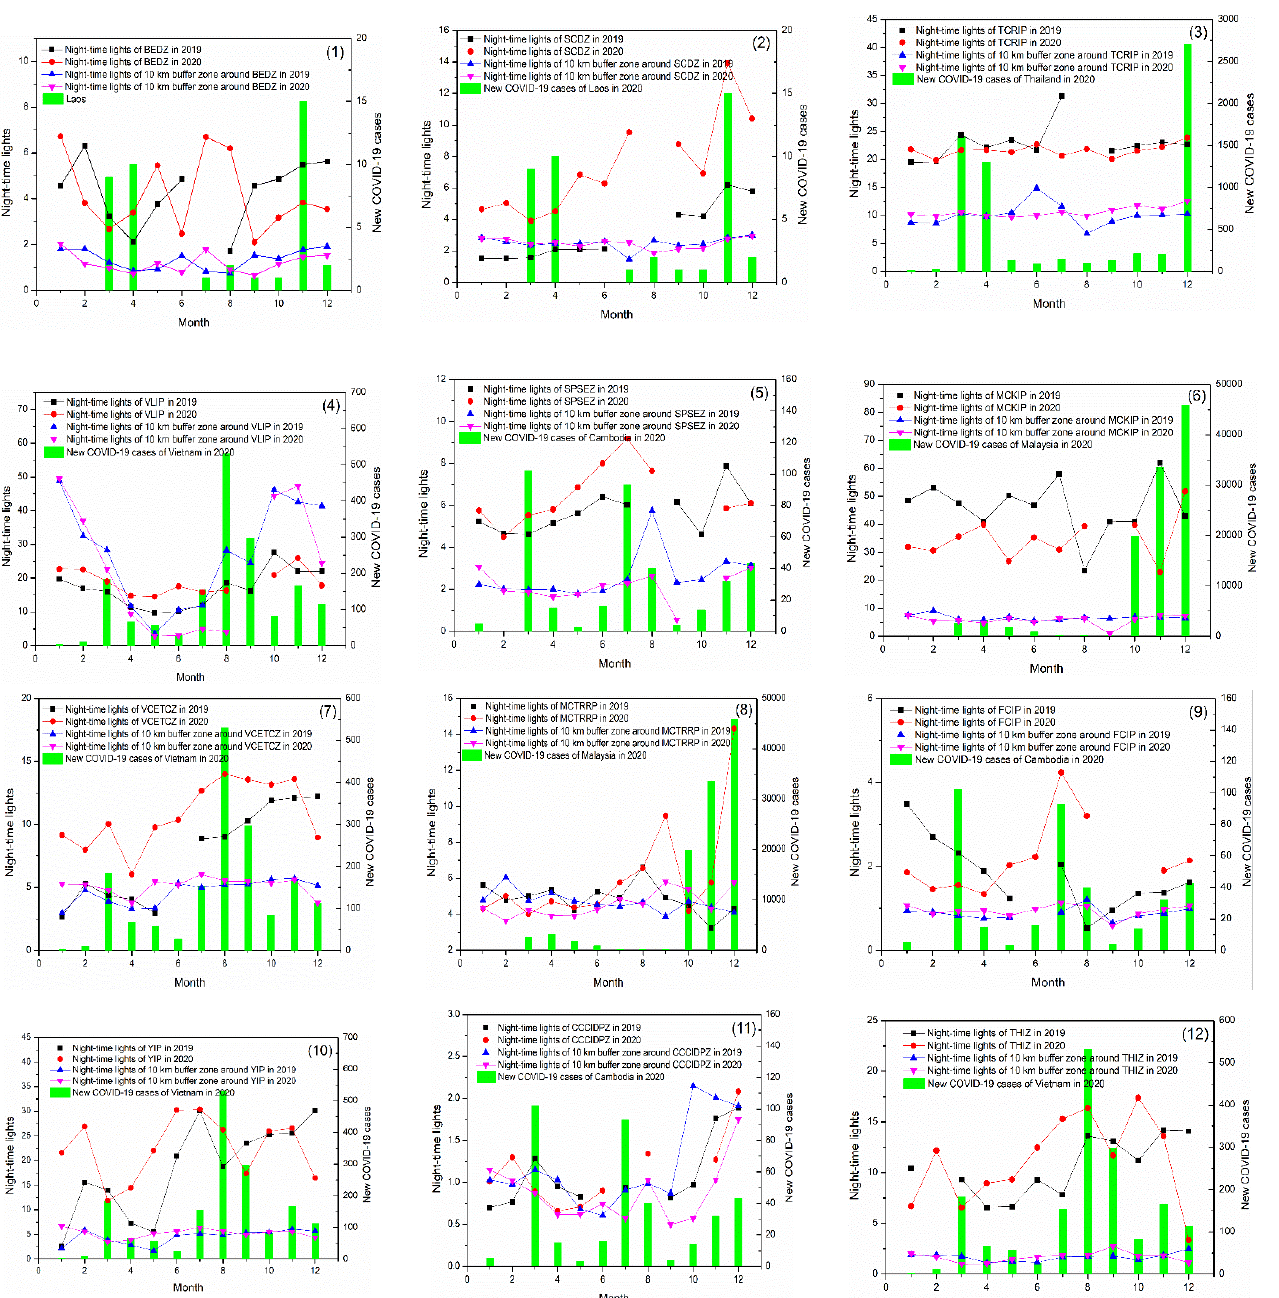
Figure 6. ( 1 )–( 12 )Time series curves of NTL at each CIPSA park and 10 km buffer zone (lines) and new COVID-19 cases (columns) in 2019 and 2020. Results of Quantitative Parameter Analysis of